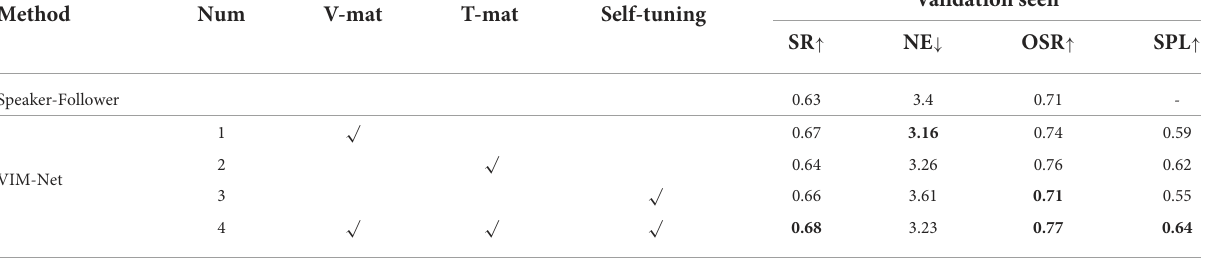
TABLE 3 The ablation study of our proposed architecture on the R2R validation set. Method